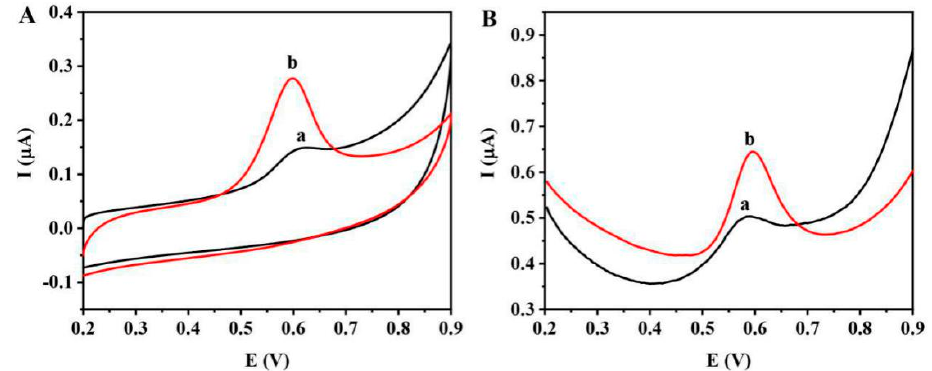
Figure 5. ( A ) Cyclic voltammograms of poly(EGDMA)/GCE (a) and poly([V 2 C 4 (mim) 2 ]Br 2 )/GCE (b) after adsorbing 2 μ M 4-NP in 0.1 M phosphate buffer (pH = 6.0) for 6 min. Scan rate: 100 mV/s. ( B ) Differential pulse voltammograms of poly(EGDMA)/GCE (a) and poly([V 2 C 4 (mim) 2 ]Br 2 )/GCE (b) after adsorbing 2 μ M 4-NP for 6 min in 0.1 M phosphate buffer (pH = 6.0).